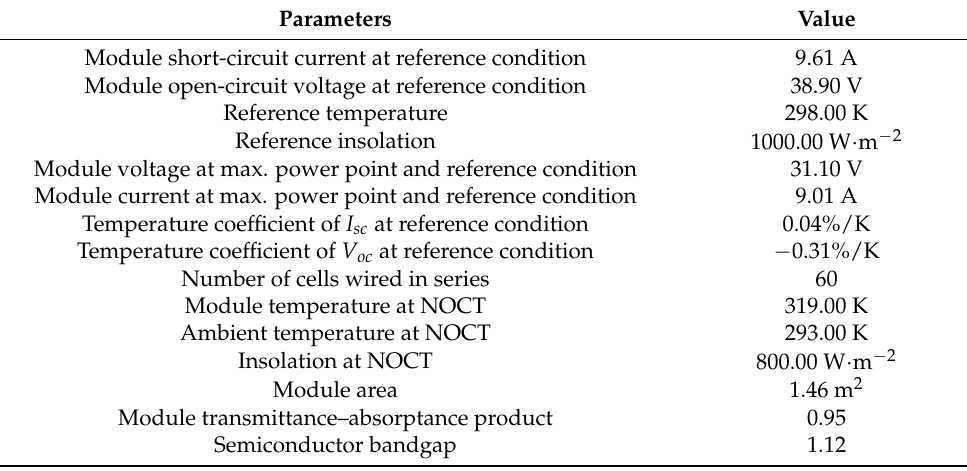
Table 1. Technical data of PV module.